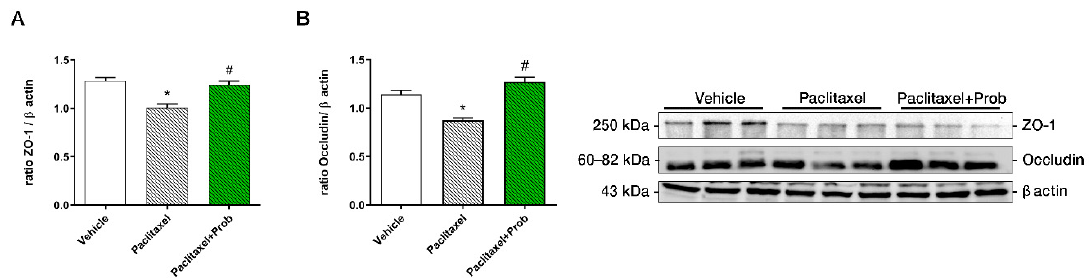
Figure 2. Western blotting analyses for ZO-1 ( A ) and occludin ( B ) in the distal colon. *, p < 0.05; vs. vehicle; #, p < 0.05 vs. paclitaxel ( n = 3). A representative figure for each protein is shown.